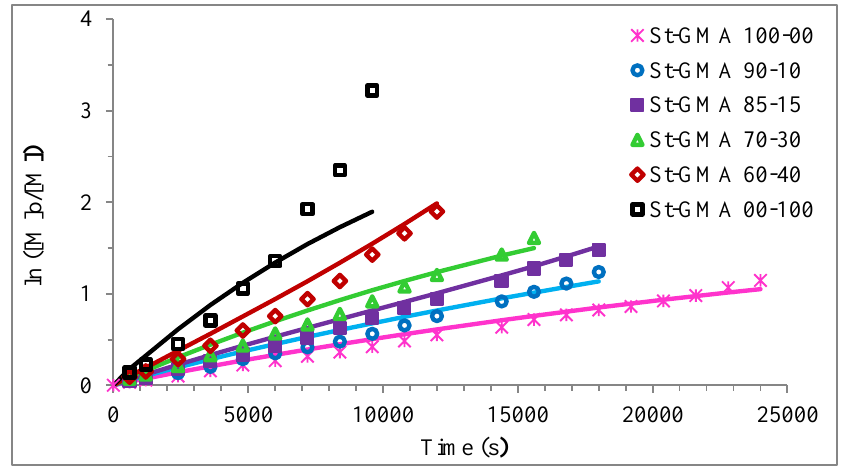
Table 9. Activation and transfer kinetic rate constants evaluated in this study. Figure 4. First-order of different St-GMA samples. Symbols represent experimental data, whereas solid lines correspond to model predictions.